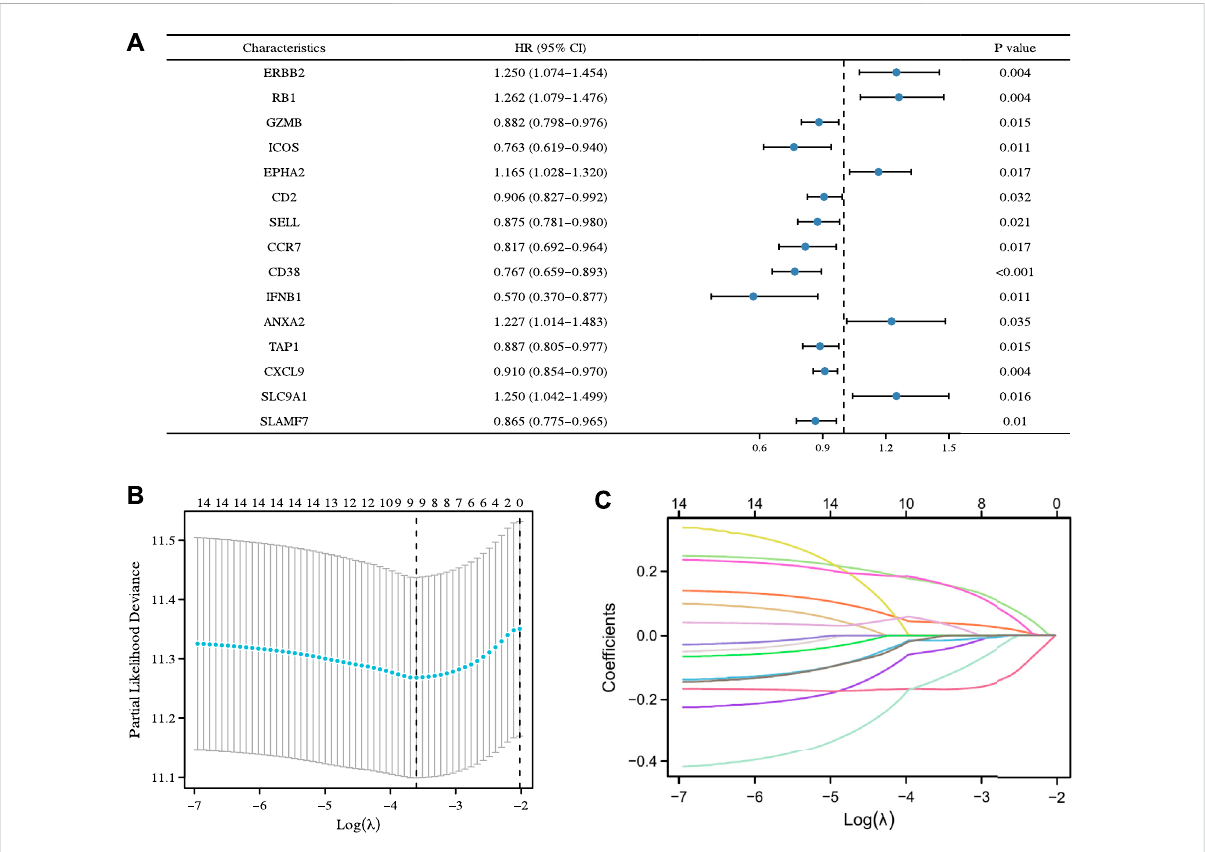
FIGURE 5 Construction of ICD-related prognostic signature in the TCGA Cohort. (A) Univariate Cox regression analysis identi fi ed 15 ICD-related genes associatedwithOSinpatientswithOC. (B) LASSOCoxregressionanalysisdetermined15ICD-relatedgenesastheoptimalcombinationfortheICD- related prognostic signature construction. (C) Plot of variable trajectories generated for log( λ ) sequences in LASSO Cox regression